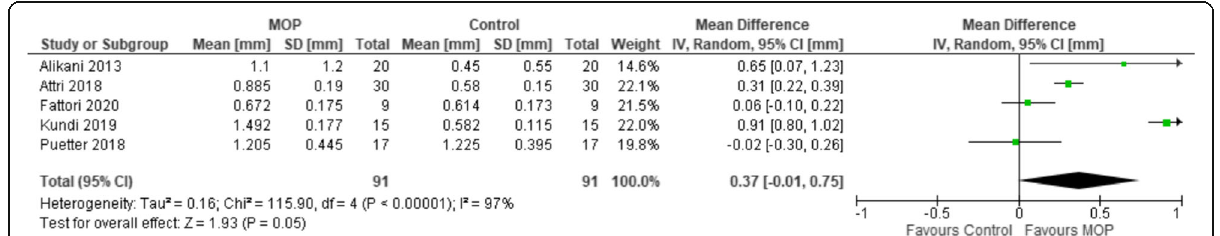
Fig. 3 Forest plot for the mean difference of the monthly rate of tooth movement comparing studies that used Propel